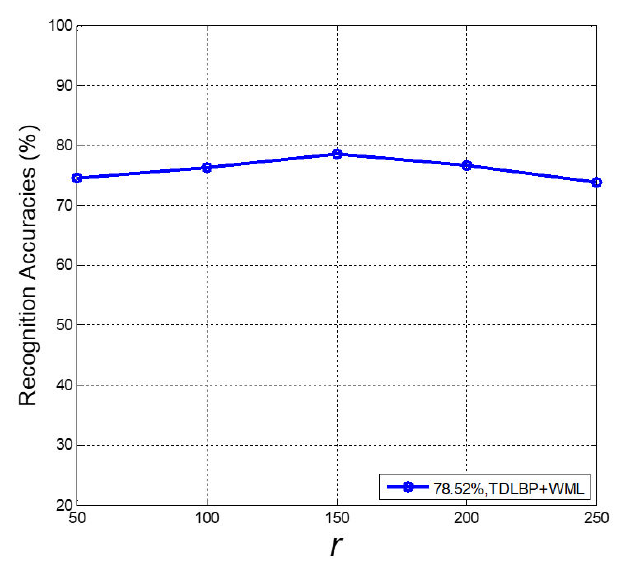
Figure 7. Recognition accuracies achieved by TDLBP + WML with varied numbers of r